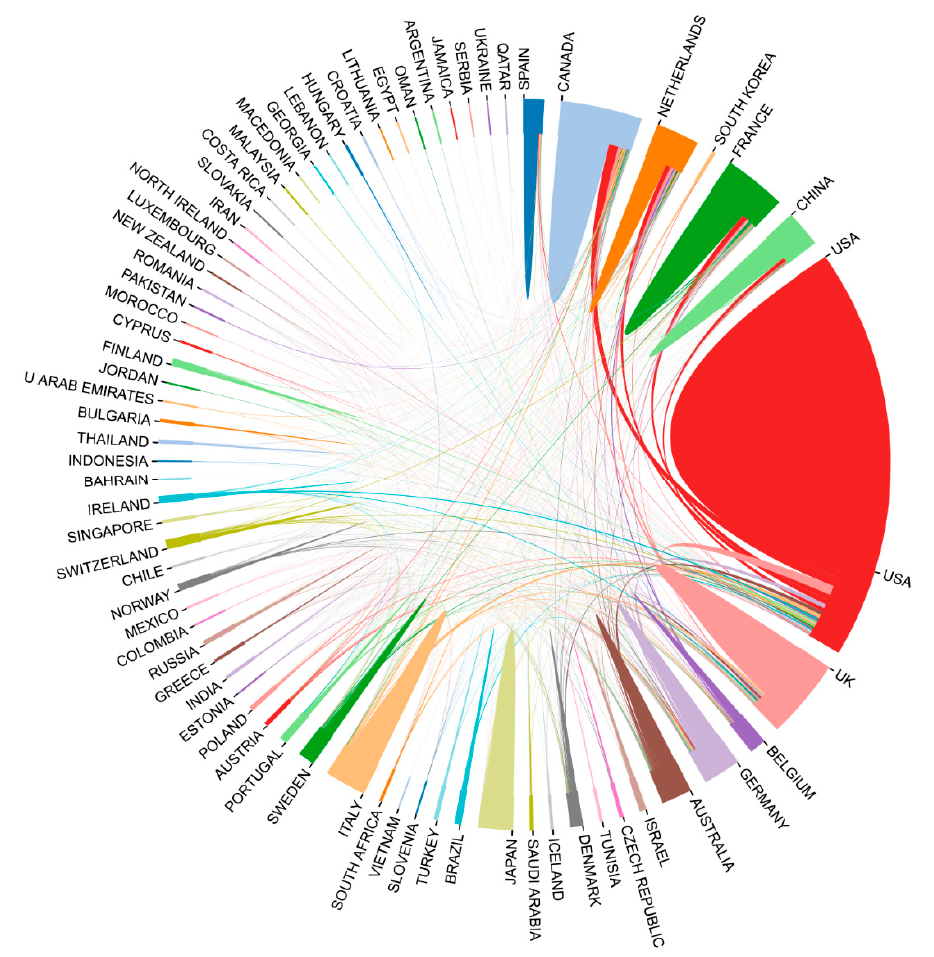
Figure 3. Cooperation between contributed countries.